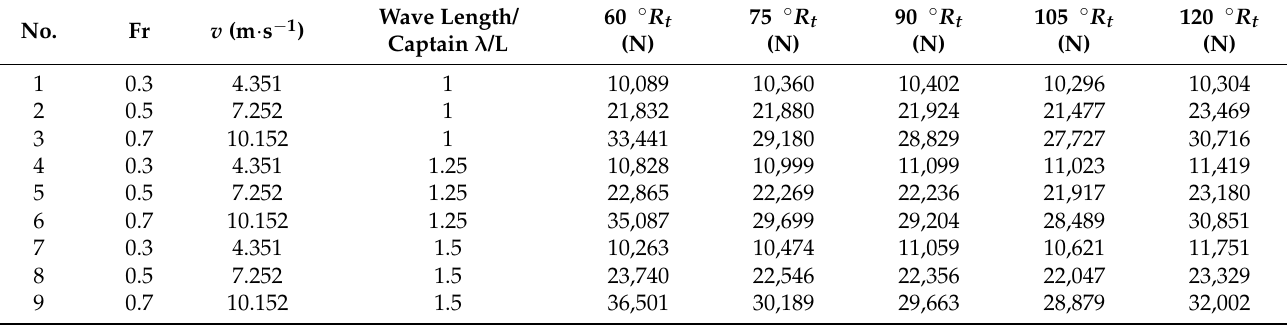
Figure 12. Time course diagram of total drag variation at three speeds for a pentamaran (λ/L = 1.25). 3.3 Discussion In this paper, a numerical simulation method was used to conduct a hydrodynamic study of an X-shaped symmetrical pentamaran, and the study focuses on the effect of the front outrigger inclination angle change on the pentamaran drag characteristics, which is